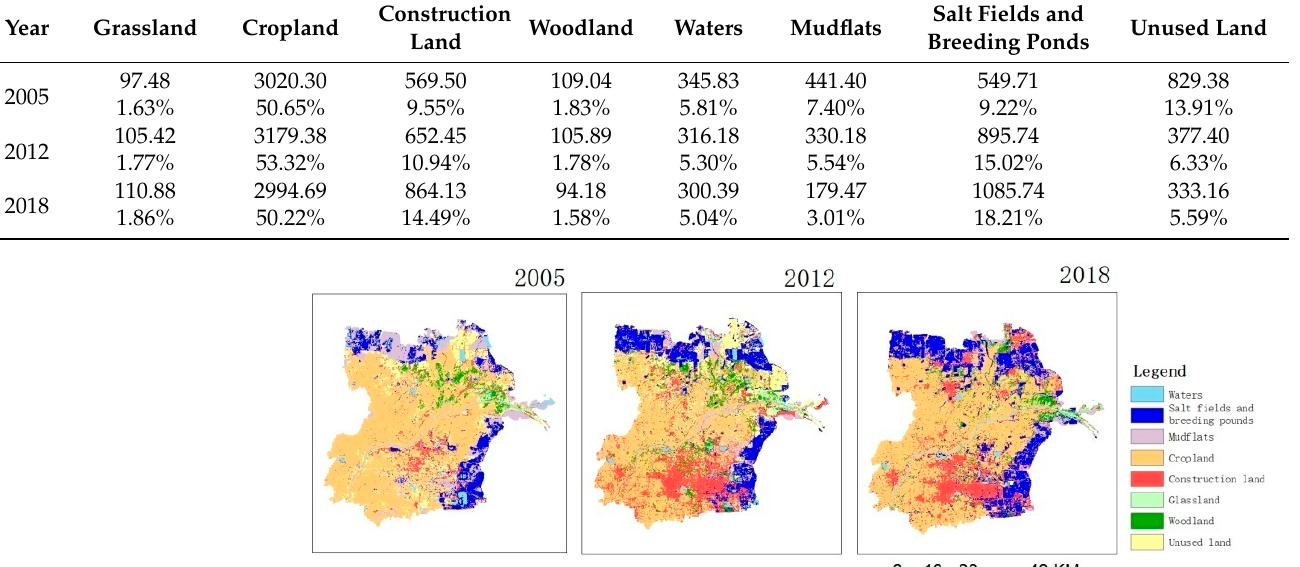
Table 2. Area of various landscape types in the Yellow River Delta(km 2 ) from2005 to 2018.